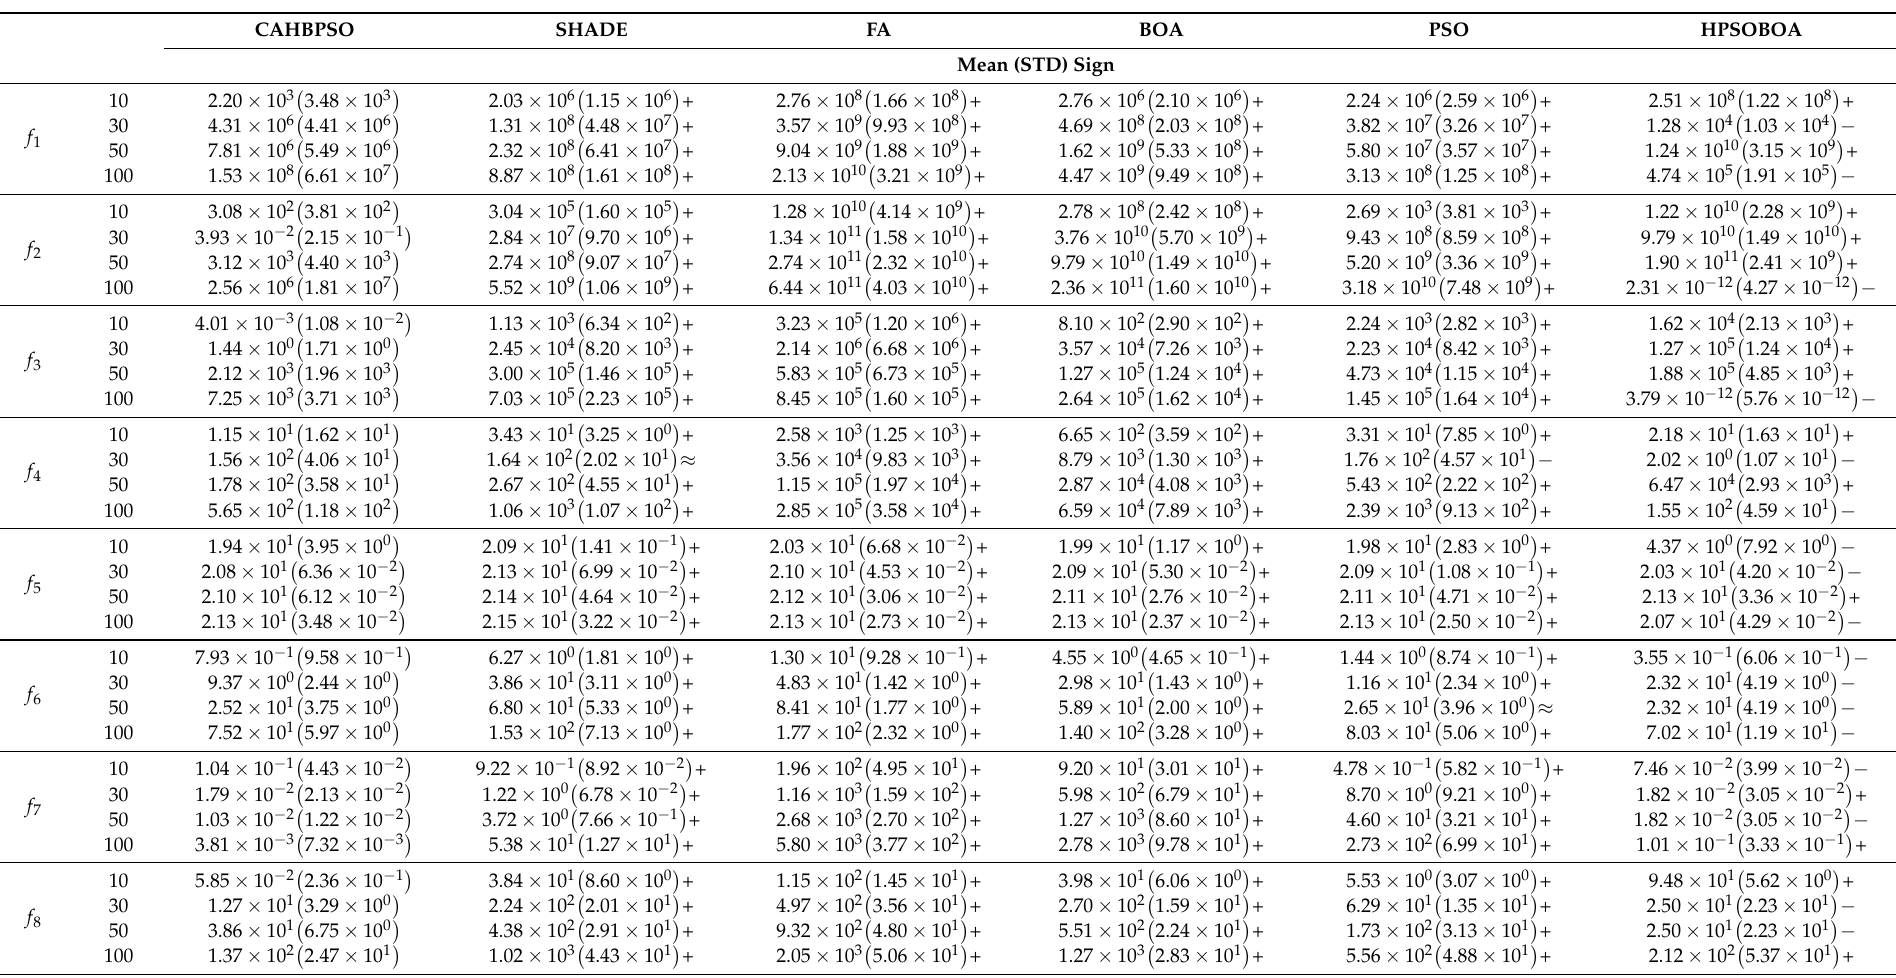
Table 1. Table presents the objective function values in terms of mean and standard deviation obtained by the considered algorithms, as a result of the numerical simulation performed on 30 CEC2014 test